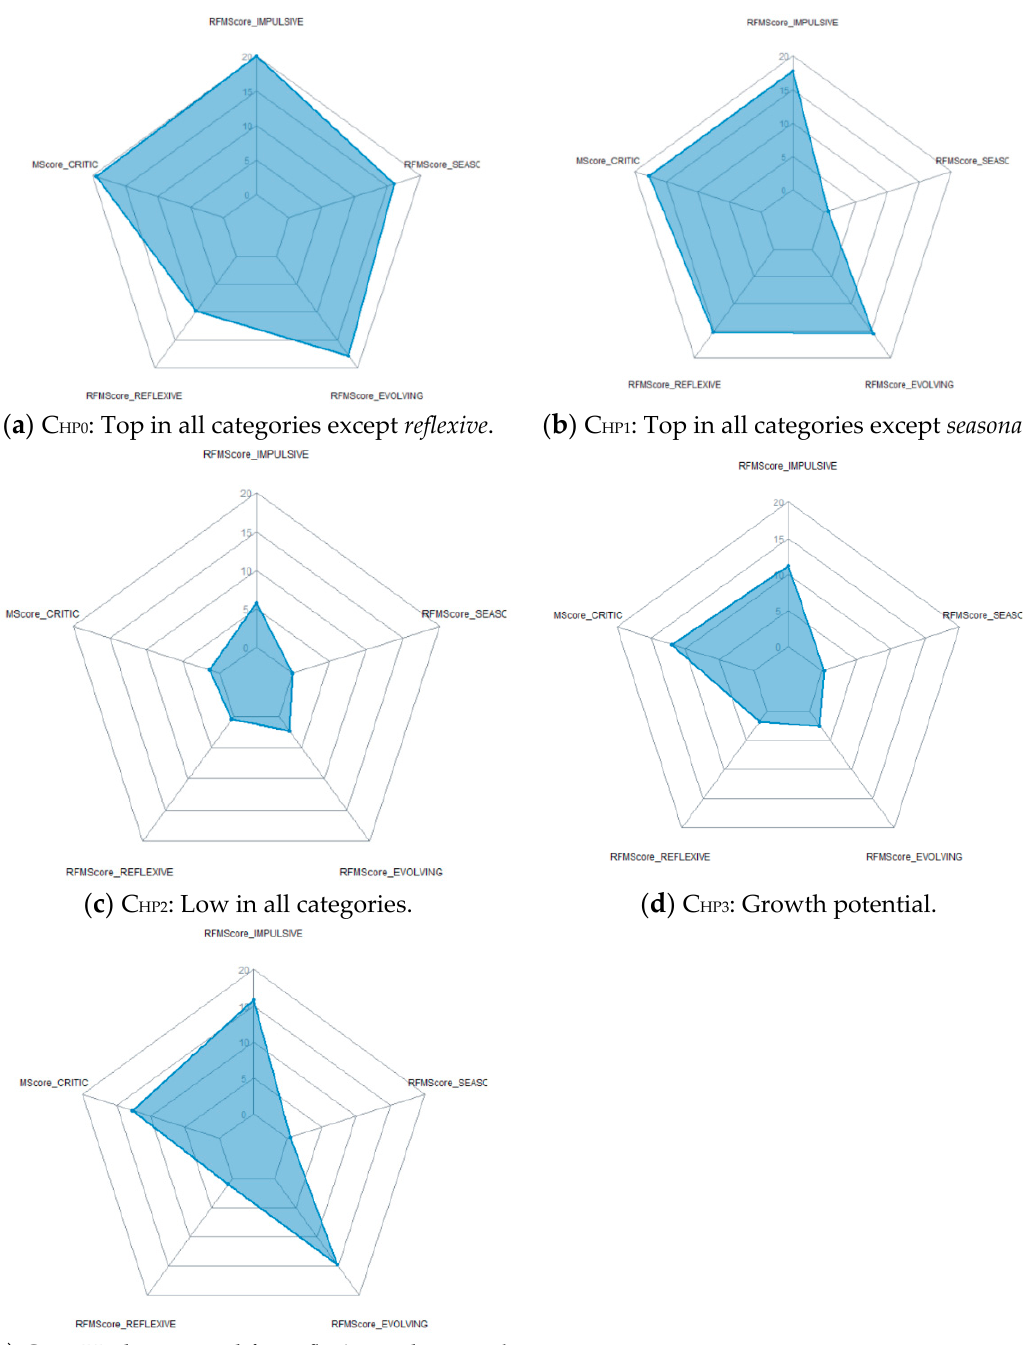
Figure 13. Radar plots per cluster C HP .